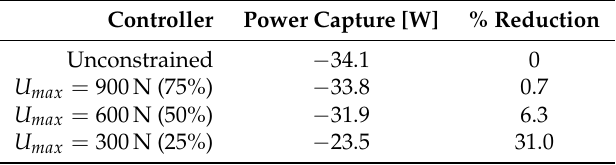
Table 4. Power captured (W and % change from unconstrained) by using unconstrained and constrained